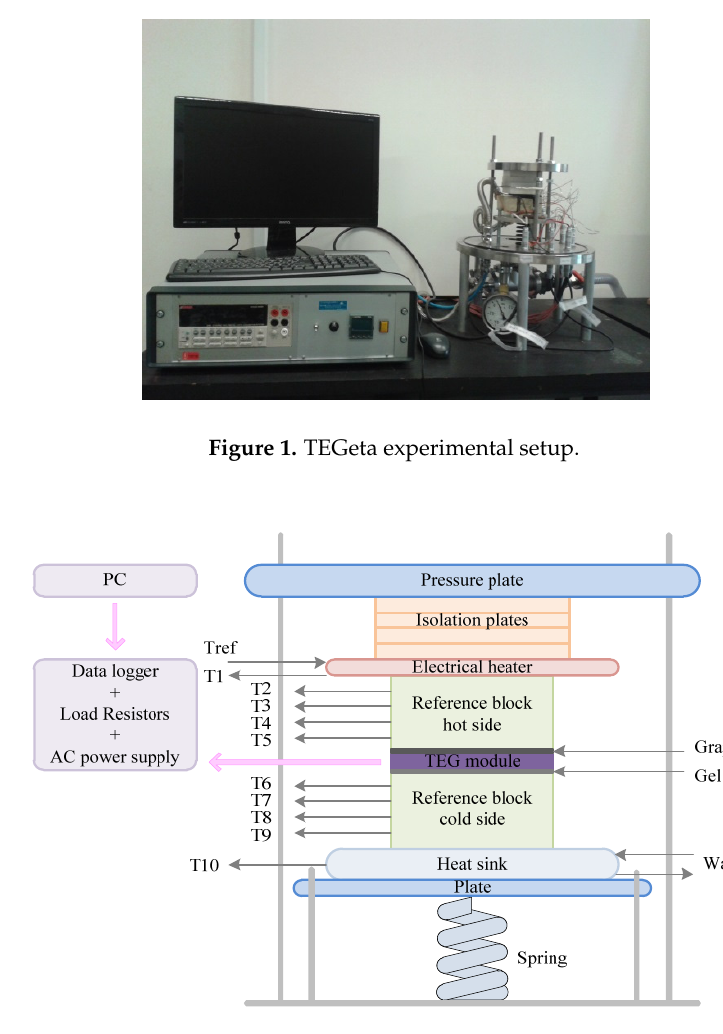
Figure 2. TEGeta block diagram.